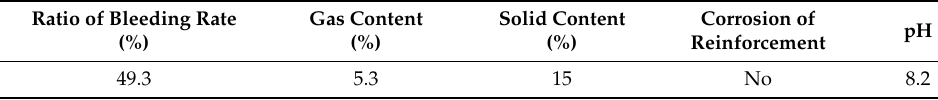
Table 2. Performance parameters of water reducer.